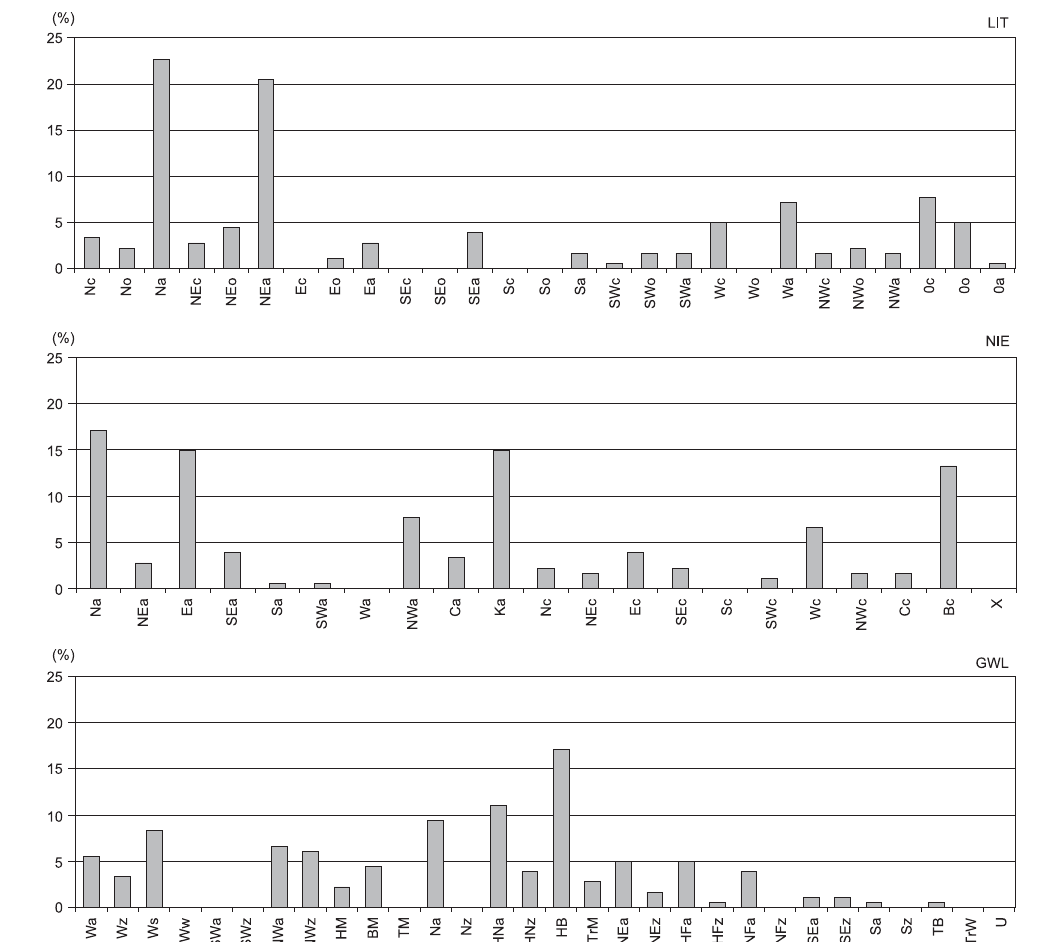
Fig. 2. Frequency of the latest spring freezes by circulation